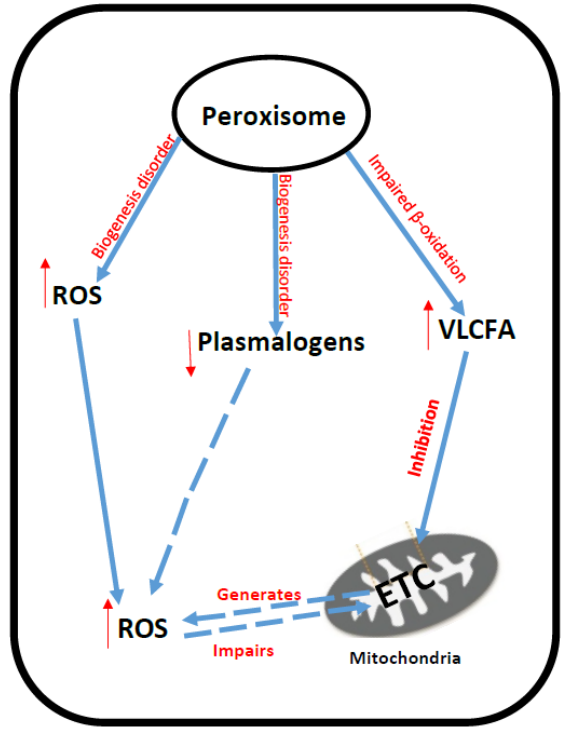
Figure 5. Putative mechanisms of oxidative stress generation and mitochondrial dysfunction in peroxisome disorders. VLCFA: Very-long-chain fatty acid; ROS: Reactive oxygen species; ETC: Mitochondrial electron transport chain.